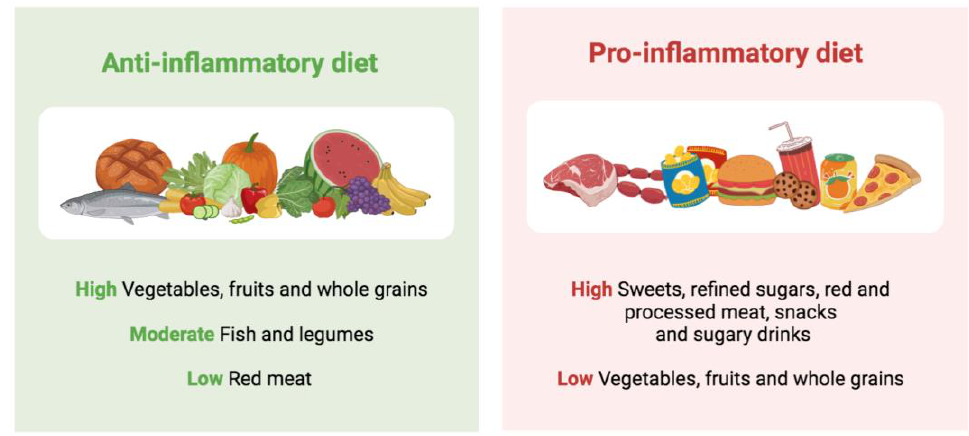
Figure 1. Dietary patterns and inflammation.